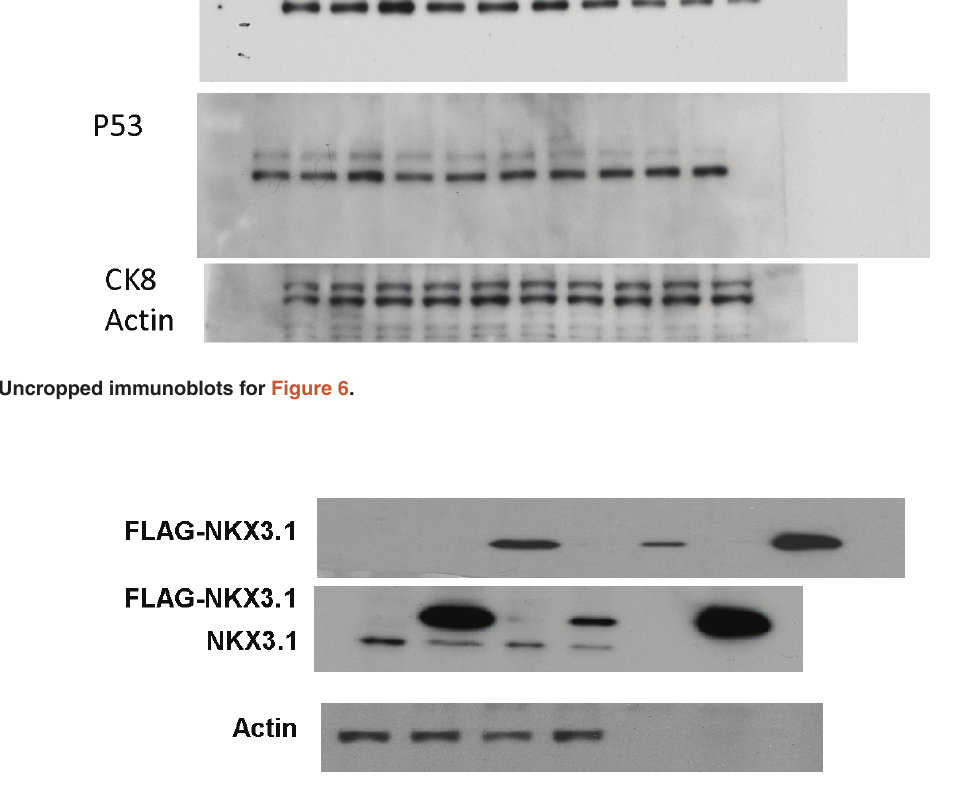
Figure S9. Uncropped immunoblots for Figure